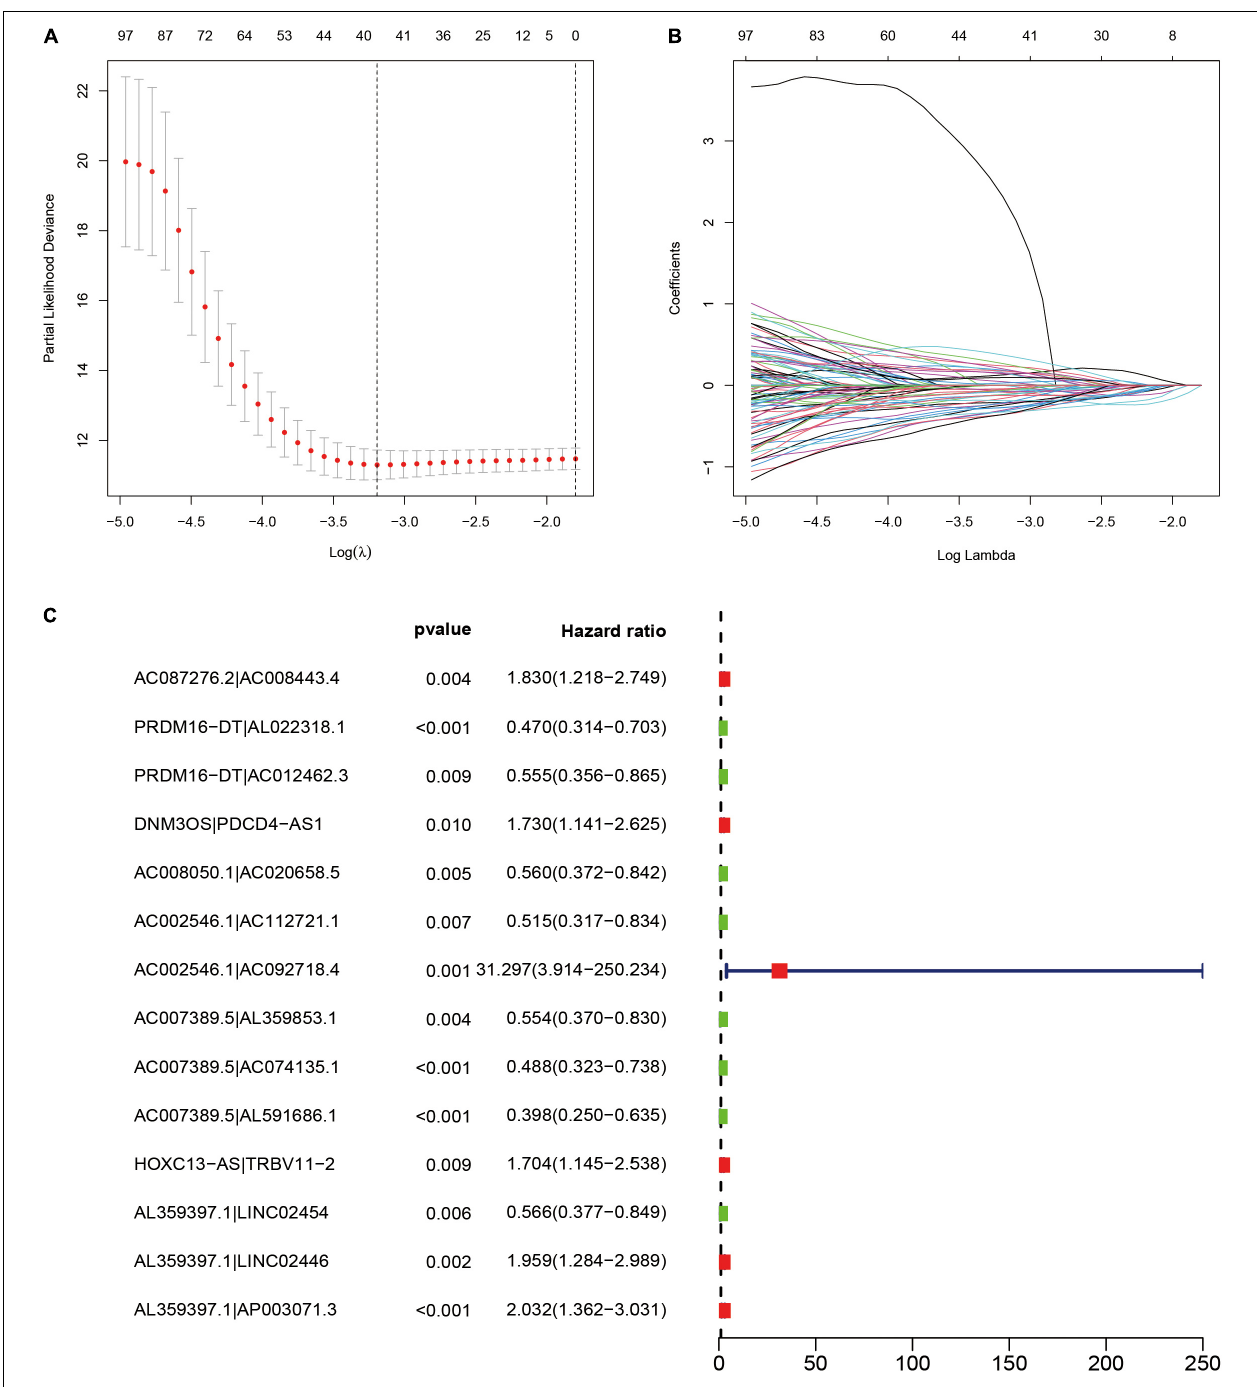
FIGURE 2 | Selection of DEirlncRNA pairs for the risk signature. (A,B) LASSO analysis with minimal lambda value. (C) Forest plot of the prognostic ability of 14 DEirlncRNA pairs identified by Cox proportional hazard regression included in the risk signature by the stepwise method.